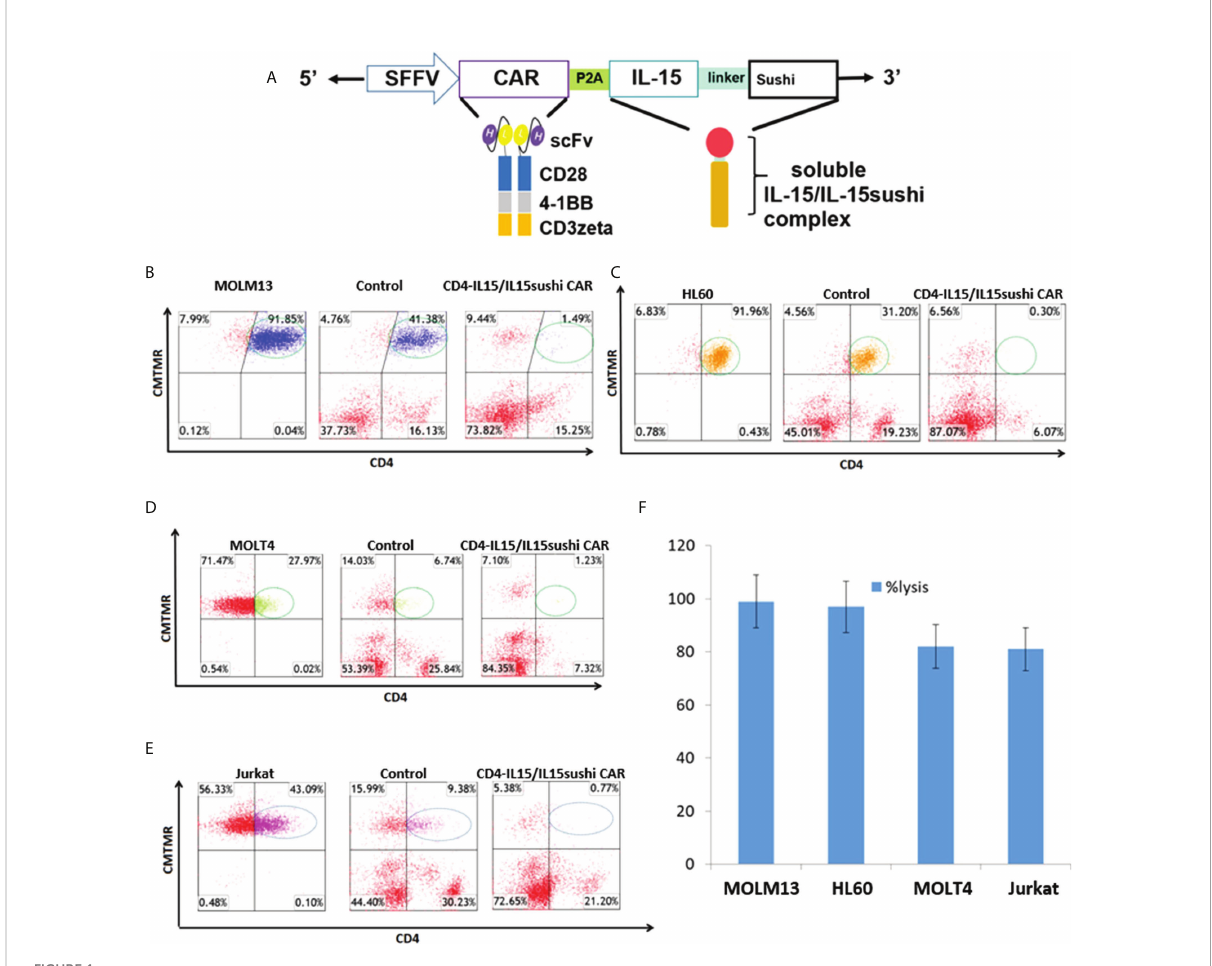
FIGURE 1 CD4-IL15/IL15sushi construct and in vitro validation. (A) Schematic representation of recombinant lentiviral vector encoding a third generation CD4 CAR linked with the P2A self-cleaving sequence to the IL-15/IL-15sushi domain of the IL-15 alpha receptor. Expression is driven by the spleen focus-forming virus (SFFV) promoter. The IL-15/IL-15sushi portion is composed of an IL-2 signal peptide fused to IL-15 and linked to the sushi domain via a 26-amino acid poly-proline linker. (B) Target MOLM13 cells expressing CD4 were co-cultured with control T cells (middle panel) or CD4-IL15/IL15sushi CAR T cells (right panel) at an E:T ratio of 2:1 for 24 hours. Left panel shows target cells alone. Target cells were pre-stained with CellTracker (CMTMR) to help distinguish from CD4-IL15/IL15sushsi CAR T cells. T cells are displayed in red. 97% of circled target population lysed compared to control in average of two experiments. (C) Target HL60 cells used in same experimental design. 99% of circled target population lysed compared to control in average of two experiments. (D) Target MOLT4 cells used in same experimental design. 82% of circled target population lysed compared to control in average of two experiments. (E) Target Jurkat cells used in same experimental design. 82% of circled target population lysed compared to control in average of two experiments. (F) Percent lysis of target population by CD4-IL15/IL15sushi CAR T cells compared to control T cells from (B – E) . Each bar represents the average of duplicate